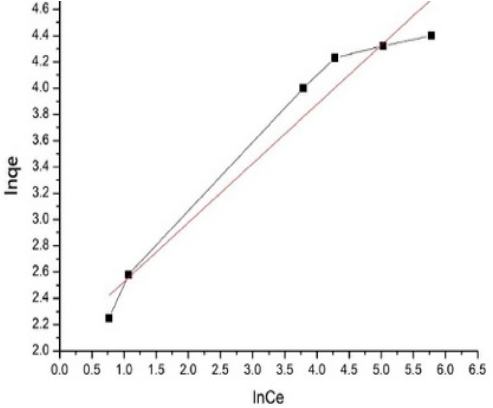
Figure 6. Freundlich isothermal adsorption curve.